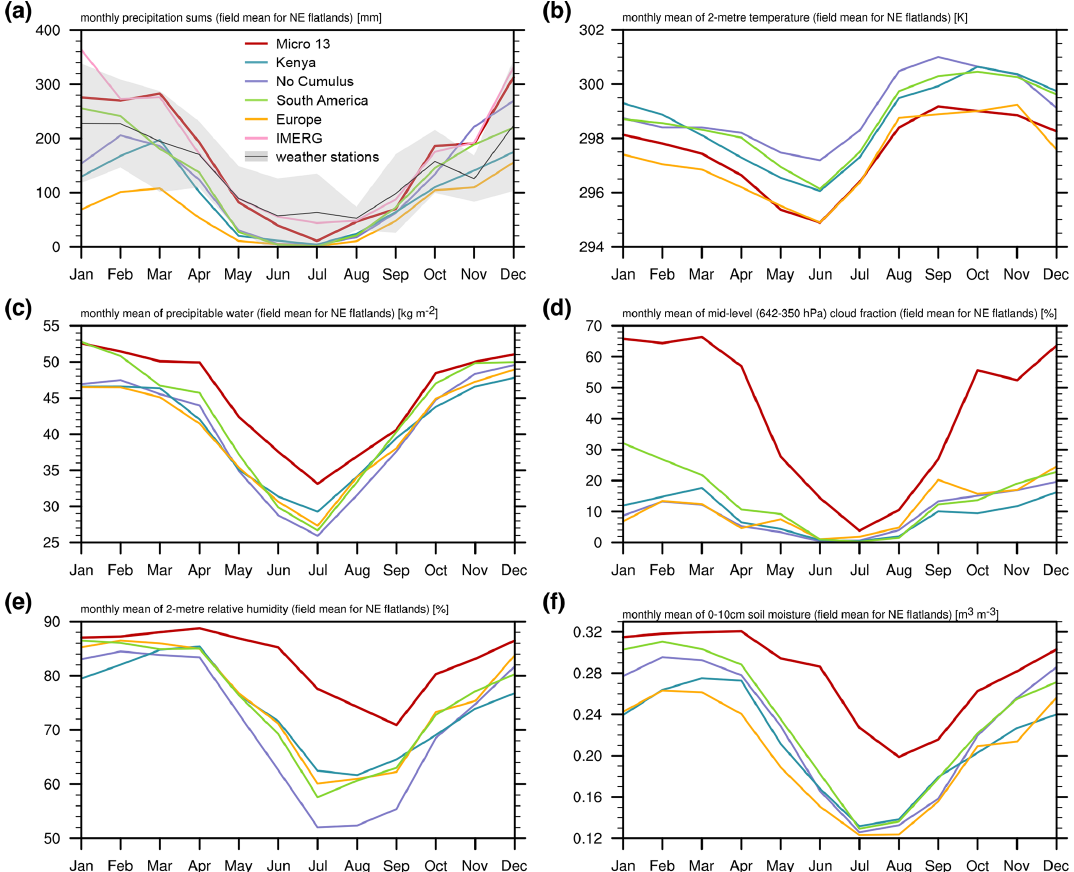
Figure 8. Seasonal cycle of a field mean over the northeastern flatlands for (a) monthly accumulated precipitation (mm), (b) monthly mean of 2m temperature (K), (c) monthly mean of precipitable water (kgm − 2 ), (d) monthly mean fraction of mid-level (642–350hPa) clouds (%), (e) monthly mean of 2m relative humidity (%), and (f) monthly mean soil moisture in the first soil layer (0–10cm, m 3 m − 3 ). Monthly accumulated precipitation (a) includes IMERG as a pink line. Additionally, the black line indicates the average of the weather station data and the grey shaded area indicates plus and minus one standard deviation. The x axis shows the months of the year.